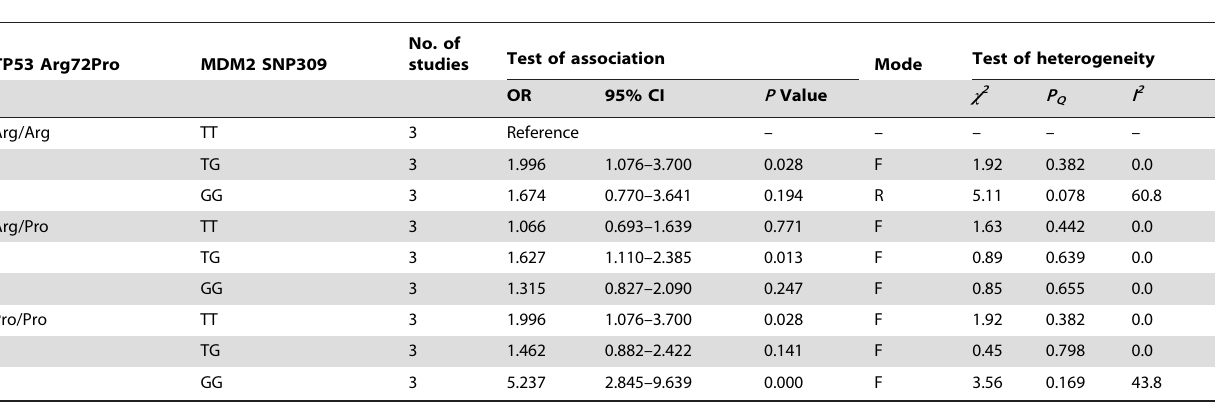
Table 4. Summary odds ratios with confidence intervals for joint effect of MDM2 SNP309 and TP53 R72P polymorphisms on HCC